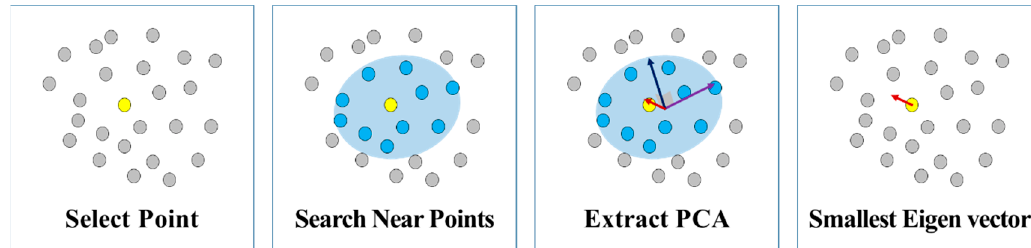
Figure 2. Estimating a surface normal vector with principal component analysis (PCA).